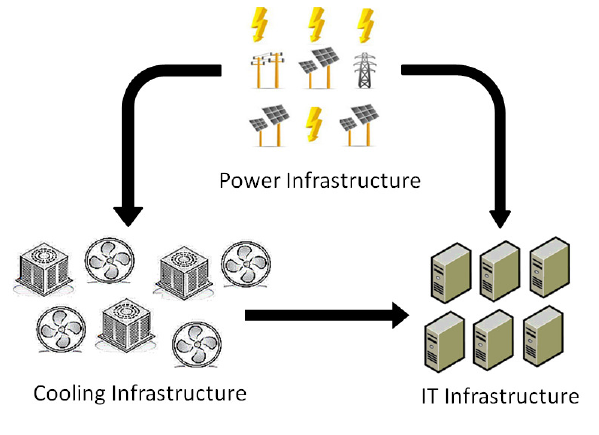
Figure 1. Data center